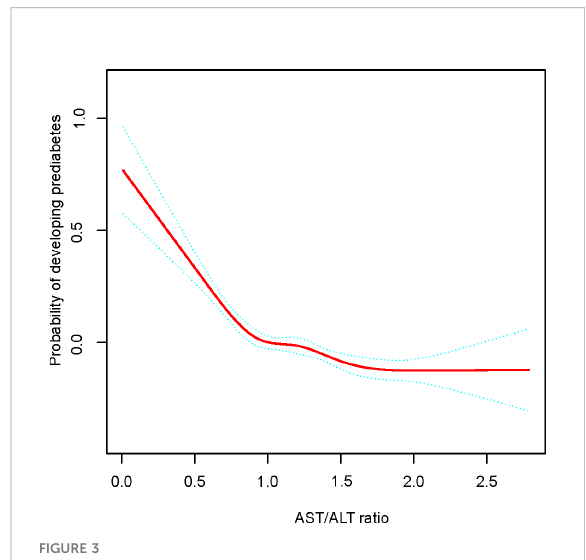
FIGURE 3 The nonlinear relationship between AST/ALT ratio and incident prediabetes. A nonlinear relationship between them was detected after adjusting for gender, age, family history of diabetes, drinking status, smoking status, SBP, DBP, BMI, TC, TG, HDL-C, LDL-C, SCr, BUN,